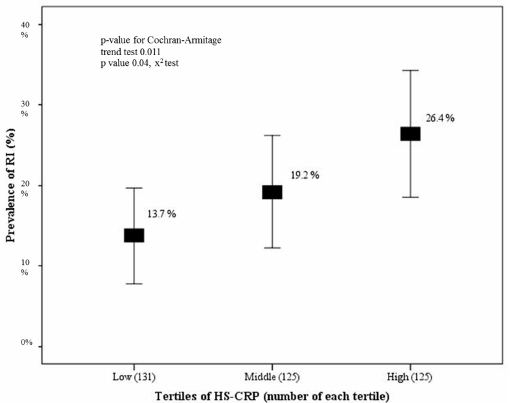
Figure 2. Prevalence of RI according to tertiles of hs-CRP levels. There was a modest linearly increasing trend across hs-CRP tertiles.